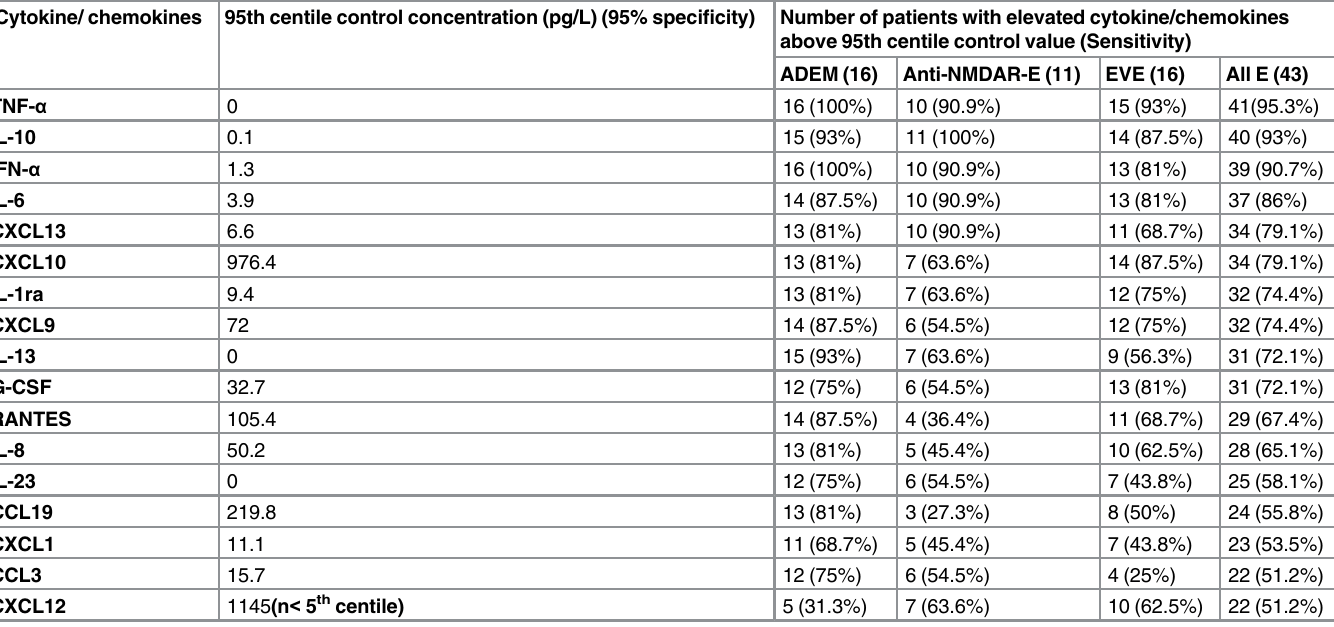
Table 2. The sensitivity of CSF cytokine/chemokines in ADEM, anti-NMDAR E, EVE and all encephalitis patients compared to controls. The mole- cules are presented in descending order of sensitivity in all encephalitis